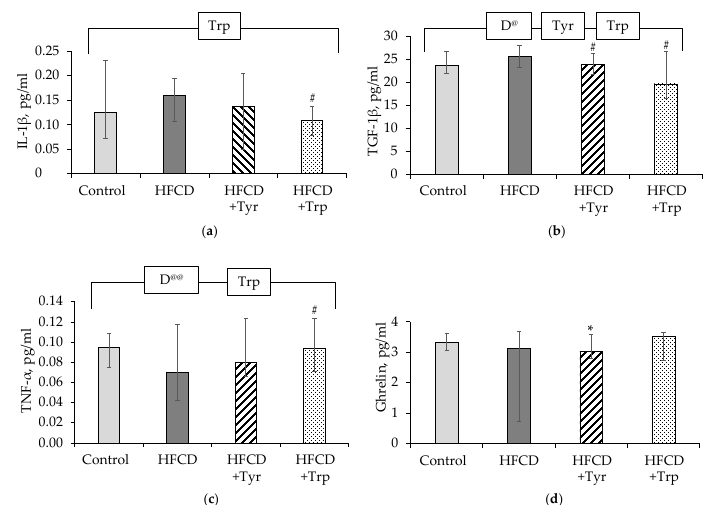
Figure 7. Levels of cytokines and adipokines in the lysates of white adipose tissue in the rats, median ± intervals of change: IL-1 β ( a ), TGF-1 β ( b ), TNF- α ( c ), ghrelin ( d ). * the difference with the control group is significant; # the difference with the group receiving HFCD is significant, p < 0.05, Mann-Whitney test. The bracket above the bars denotes significant dependence on the factors: “diet” (D), “tyrosine” (Tyr), “tryptophan” (Trp), p < 0.05, 3-way ANOVA. Indices @ excluding rats receiving Trp, @@ excluding rats receiving Tyr. The numbers of animals in the groups were 8.